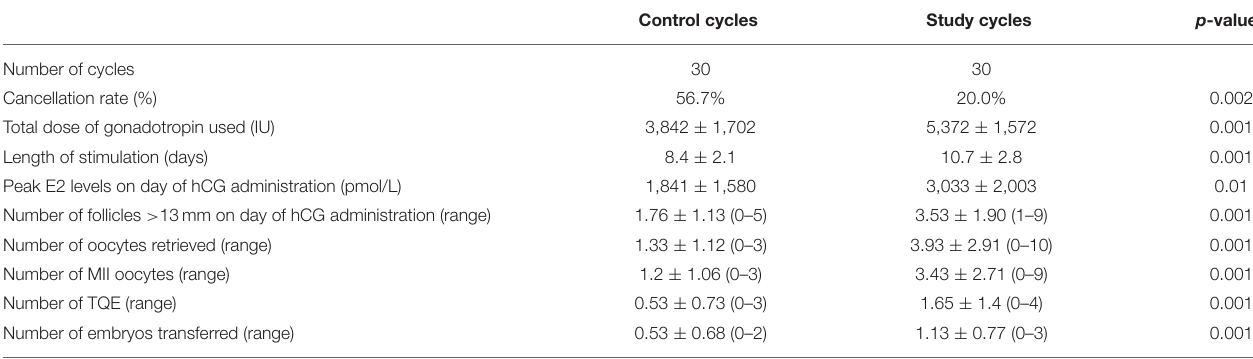
TABLE 1 | Clinical characteristics of the IVF cycles in the two study groups.